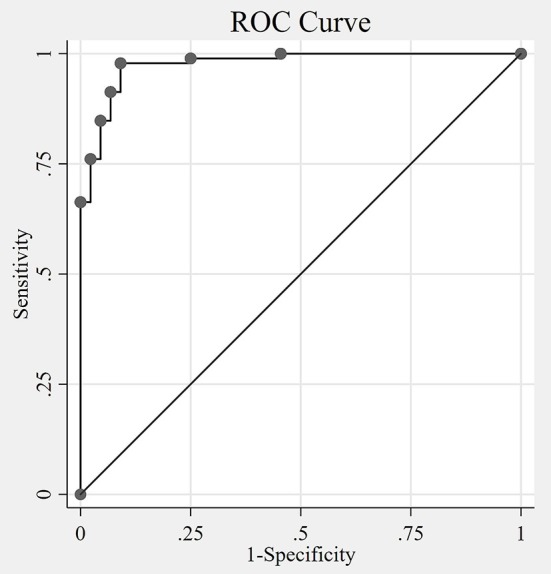
The Receiver Operating Characteristic (ROC) curve. The non-parametric ROC curve depicts the tradeoff of sensitivity and specificity of the VANS identifying polyneuropathy at different cutoff values of VANS scores. The area under the curve (AUC) is 0.98 (95% CI 0.95 to 0.99), with an AUC of 1 indicating perfect agreement between the VANS PN indicator and the actual disease status. The optimal cutoff by both Liu and Youden methods is 2 (meaning VANS scores >2 indicates the presence of PN). VANS, VA Neuropathy Scale; CI, confidence interval; PN, polyneuropathy.